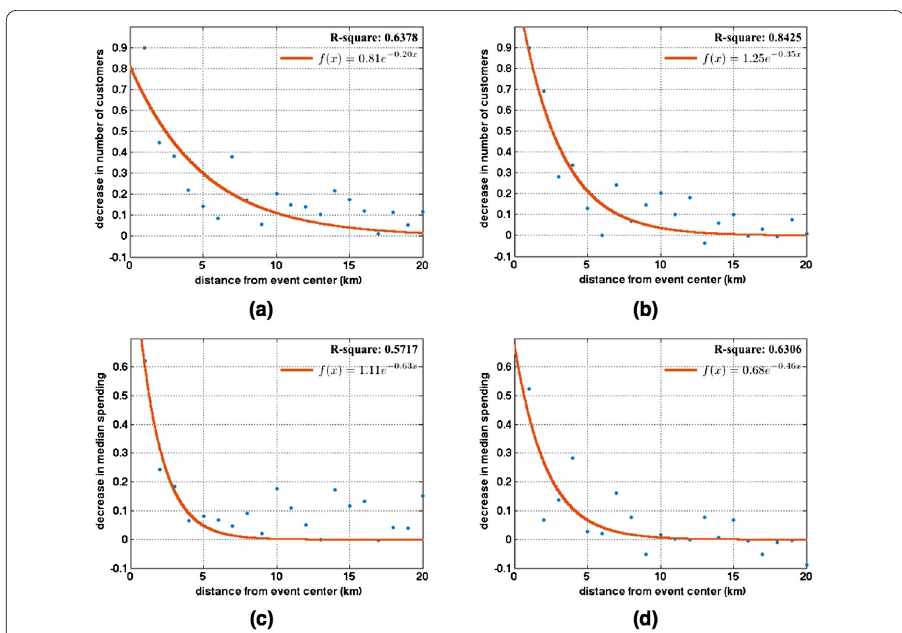
Figure 5 The exponential fit to the median magnitude of decrease in the two behavioral indexes for neighborhoods that are located at different distances from the event center: ( a ) number of customers on Day 62; ( b ) number of customers on Day 77; ( c ) median spending on Day 62; ( d ) median spending on Day